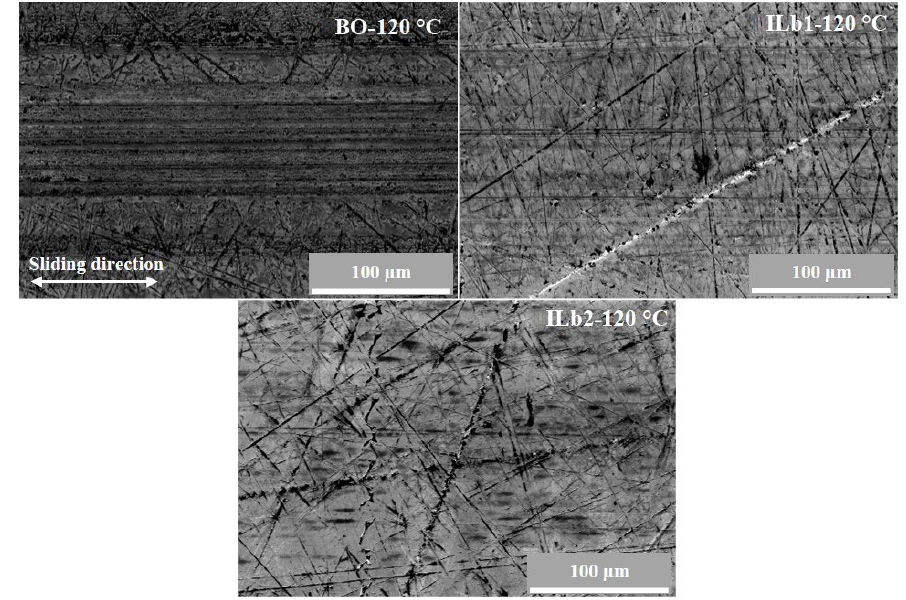
Fig. 9 SEM images of the SRV test wear track of BO, ILb1, and ILb2 at 120